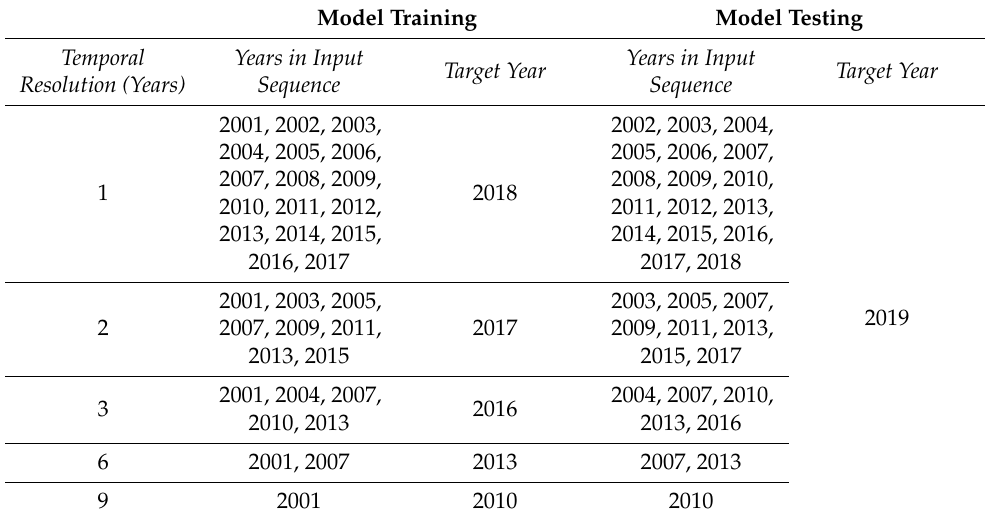
Table 6. Years used in real-world data experiments for training and